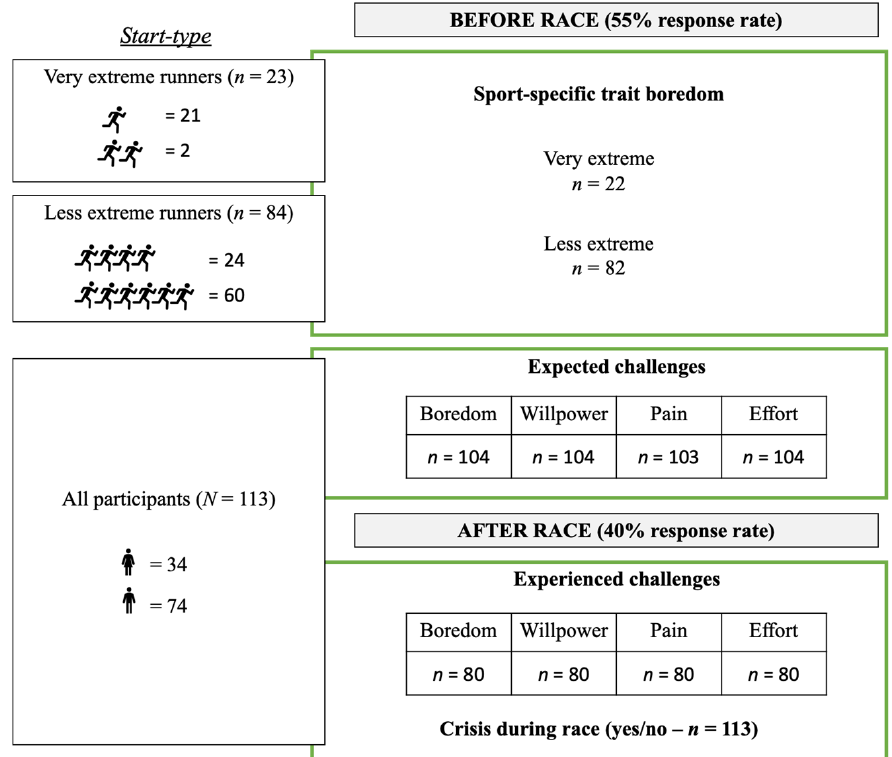
Figure 1. The different questionnaires or single items were not fully answered by all participants. This overview shows transparently which quantity of responses were included in the statistics. The visualization shows, analogous to the applied statistical methods, data for the question about trait boredom, a separation into very extreme and less extreme, as well as for all other questions answered by the whole sample.